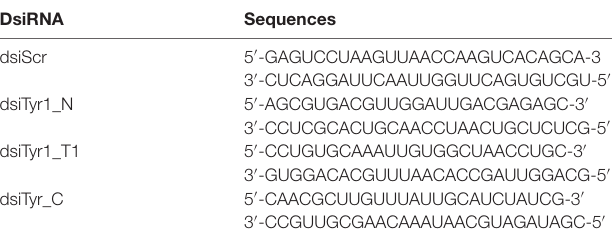
TABLE 2 | Nucleotide sequences of sense and antisense strands of control DsiSCR and AmTyr1